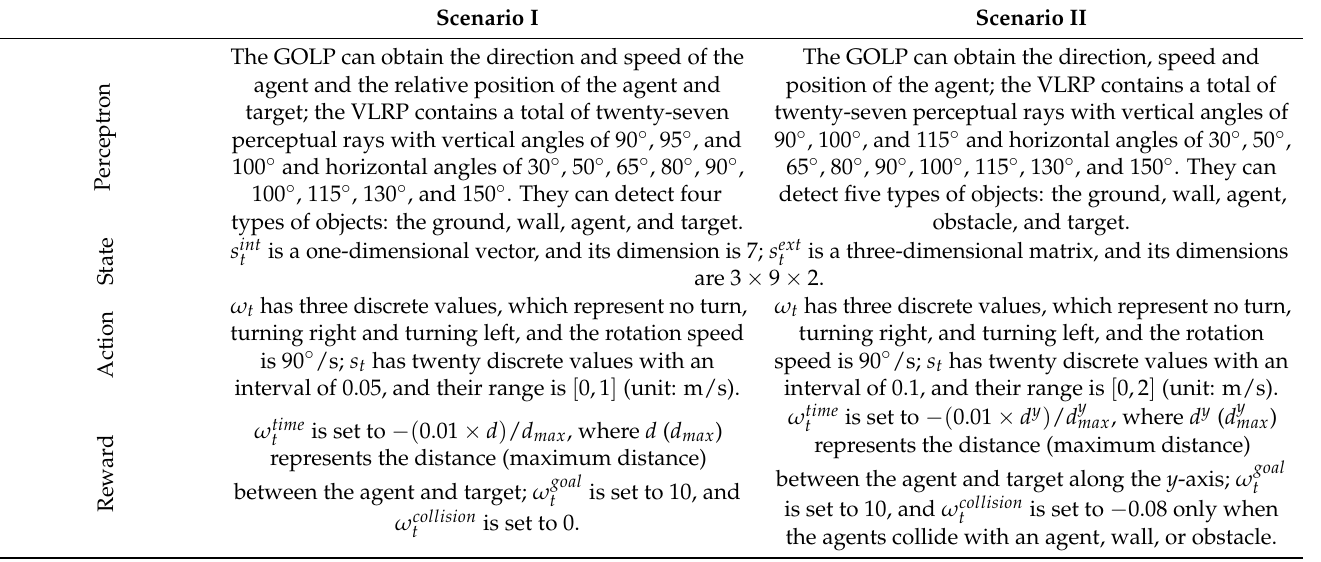
Table 1. Configuration of Agent and